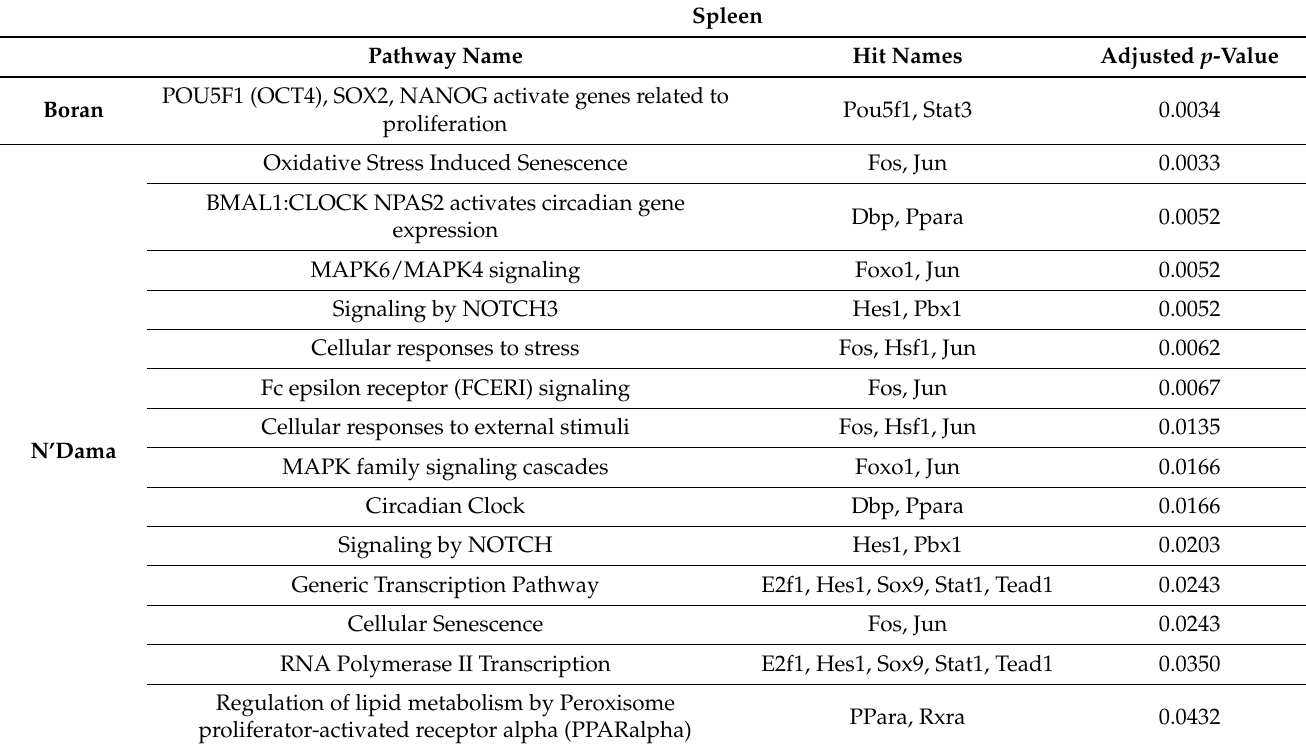
Table 4. Significantly over-represented pathways found for the spleen tissue of Boran and N’Dama ( p -adjusted < 0.05).